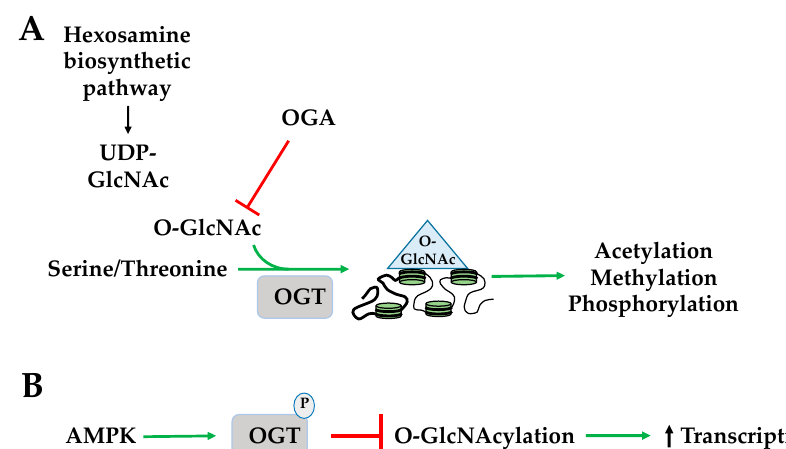
Figure 5. AMPK regulates histone O -GlcNAcylation and ADP-ribosylation. ( A ) O -GlcNAc transferase adds O -GlcNAc to a serine or threonine to produce O -GlcNAcylation. Nutrient and stress sensor stimulates hexosamine biosynthetic pathway (HBP) to create UDP-GlcNAc, which is a donor substrate for O -GlcNAcylation. Histone O -GlcNAcylation regulates acetylation, methylation, and phosphorylation; ( B ) AMPK phosphorylates O -GlcNAc transferase and inhibits O -GlcNAcylation to increase transcription. OGA: O -GlcNAcase; OGT: O -GlcNAc transferase.